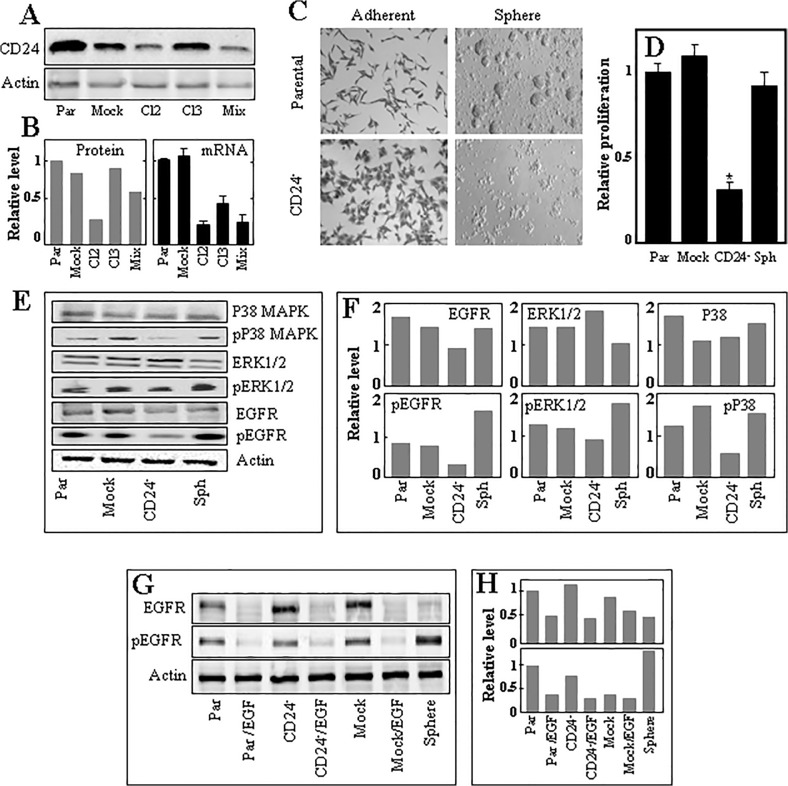
CD24 is important for mesosphere formation and MM cell proliferation.(A) Parental, mock-transfected, clone 2, clone3 and ‘mixed’ cells (Ist-Mes-2 cells transfected with CD24 shRNA and selected for several clones) were assessed for CD24 using western blotting with actin as the loading control. Relative level of CD24 in the cells is shown based on densitometric evaluation in panel B, which also document CD24 mRNA level related to GAPDH. (C) Parental and CD24- Ist-Mes-2 cells (clone 2) were grown either in the serum-containing medium or the SFM. (D) Parental, mock-transfected and CD24- adherent and sphere Ist-Mes-2 cells were assessed for proliferation at 48 h after seeding in culture at identical cell number using the crystal violet assay. (E) Parental, mock-transfected and CD24- adherent and sphere Ist-Mes-2 cells were evaluated for P38, pP38 MAPK, ERK1/2, pERK1/2, EGRF and pEGRF by western blotting with anti-actin IgG as a loading control, with densitometric evaluation of the blots in panel F. (G) Parental, CD24- or mock transfected cells grown either in the complete medium or in complete medium supplemented with recombinant EGF, or sphere cells grown in the SFM were assessed for EGFR and pEGFR by western blotting using anti-actin IgG as a loading control, with densitometric evaluation shown in panel H. Data in panels B (right panel) and D are mean values ±S.D., and are derived from three individual experiments. The symbol ‘*’ denotes statistically significant differences with p<0.05. Images in panel C are representative of three independent experiments, and images in panels A, E and G of two individual experiments. The densitographic evaluations in panels B (left), F and H are average values of two evaluations with differences less than 10%.